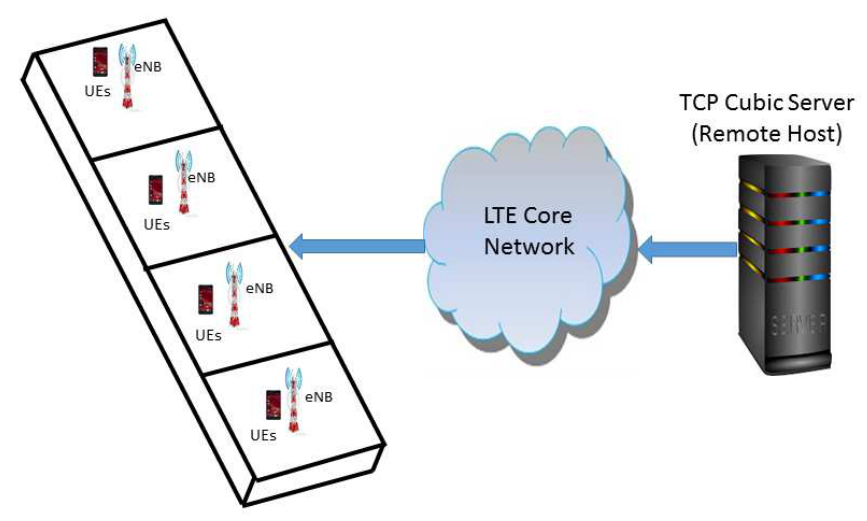
Figure 7. Multi-cell LTE network